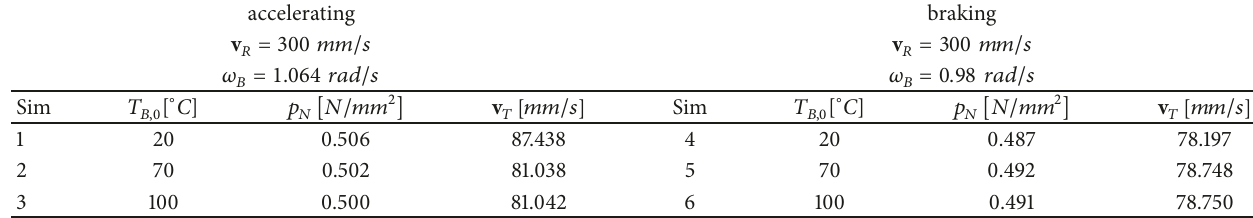
Table 3: Loading and boundary conditions in the simulation of a rubber block moving on a tire-rotation-like displacement path. accelerating